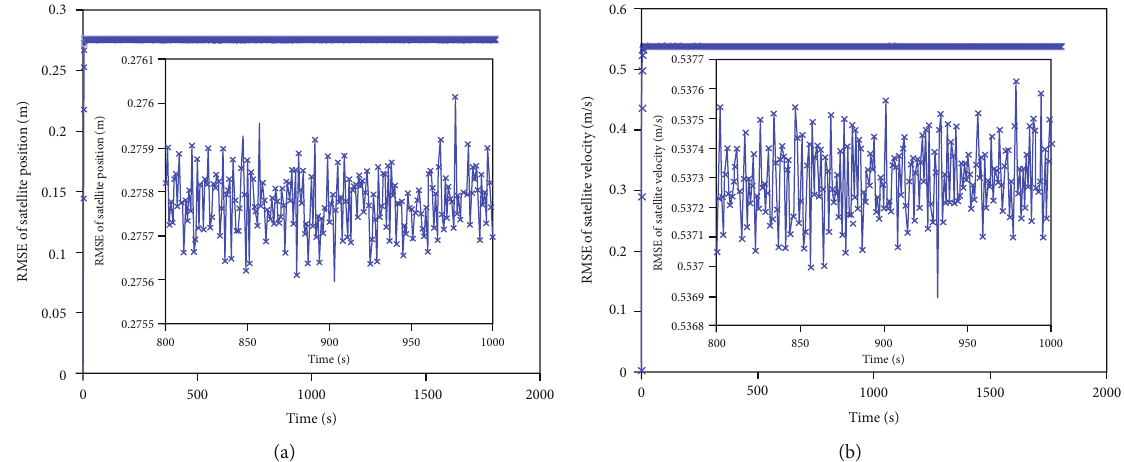
Figure 7: RMSE of satellite position and velocity under the action of 500 μ N thrust.